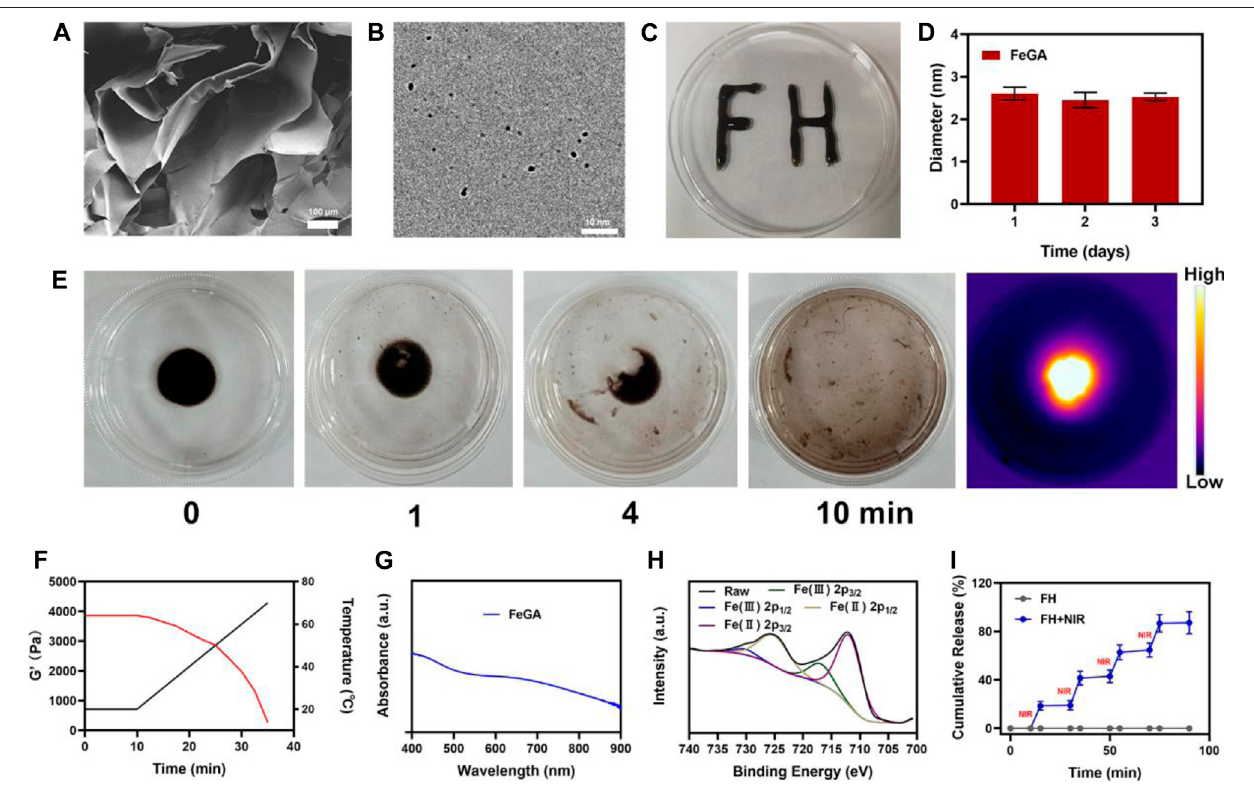
FIGURE 1 | (A) SEM image of hydrogel. (B) TEM image of FeGA. (C) Written using the prepared FH via syringe, demonstrating the stability of this compound. (D) StatisticalgraphofmeasureddiametersizeofFeGA. (E) ThemorphologyofthepreparedFHbeforeandafter0.5 W/cm 2 808 nmlaserirradiationfor10 minandinfrared thermal images of the prepared FH following irradiation. (F) Rheological and temperature curves (red and black, respectively) for the prepared FH under conditions that simulate anexposureto0.5 W/cm 2 808 nm laserirradiation. (G) FeGAabsorbancespectra. (H) XPSspectraofFe2p orbit inFeGA. (I) Invitro FeGArelease pro fi le in the presence and absence of 808 nm laser irradiation, with NIR being used to indicate irradiation time points.